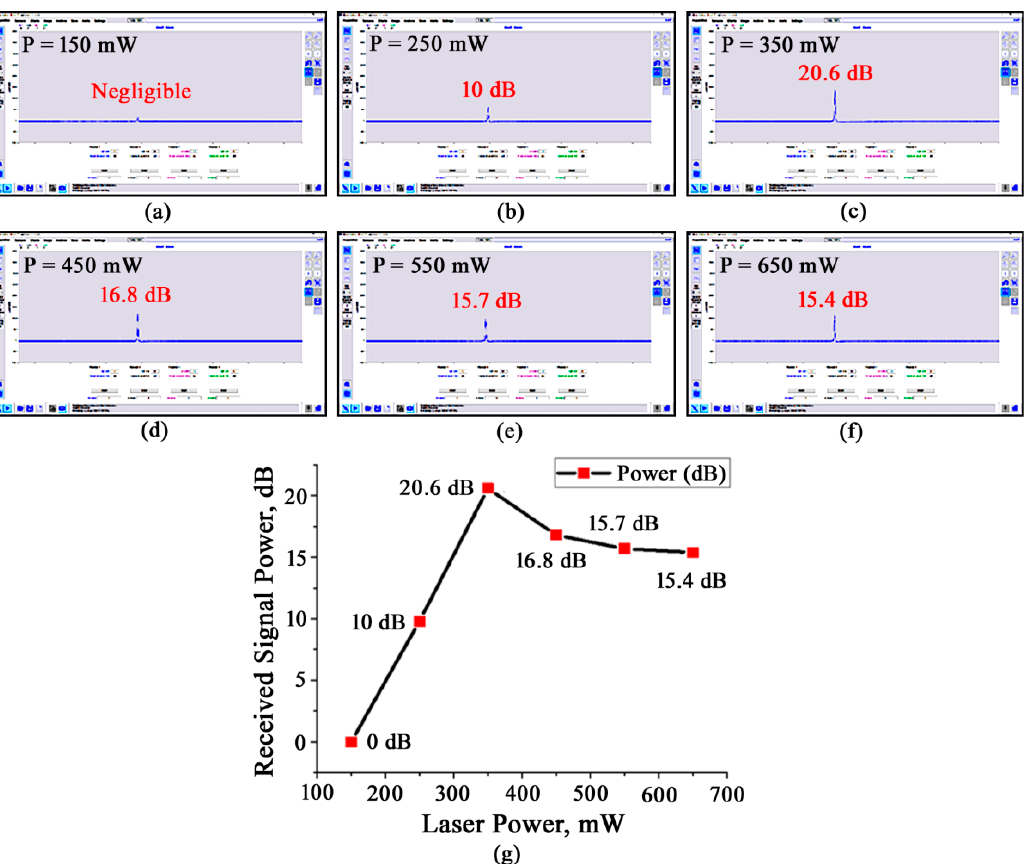
Figure 6. Interrogator-assisted measurement of the received signal power (at λ B = 1542 nm) reflected back from the 15-mm-long FBGs fabricated under different laser powers (P) for an exposure time of 15 s. ( a ) P = 150 mW; ( b ) P = 250 mW; ( c ) P = 350 mW; ( d ) P = 450 mW; ( e ) P = 550 mW; ( f ) P = 650 mW; ( g ) dependence of the received signal power on the irradiation power of the laser beam.